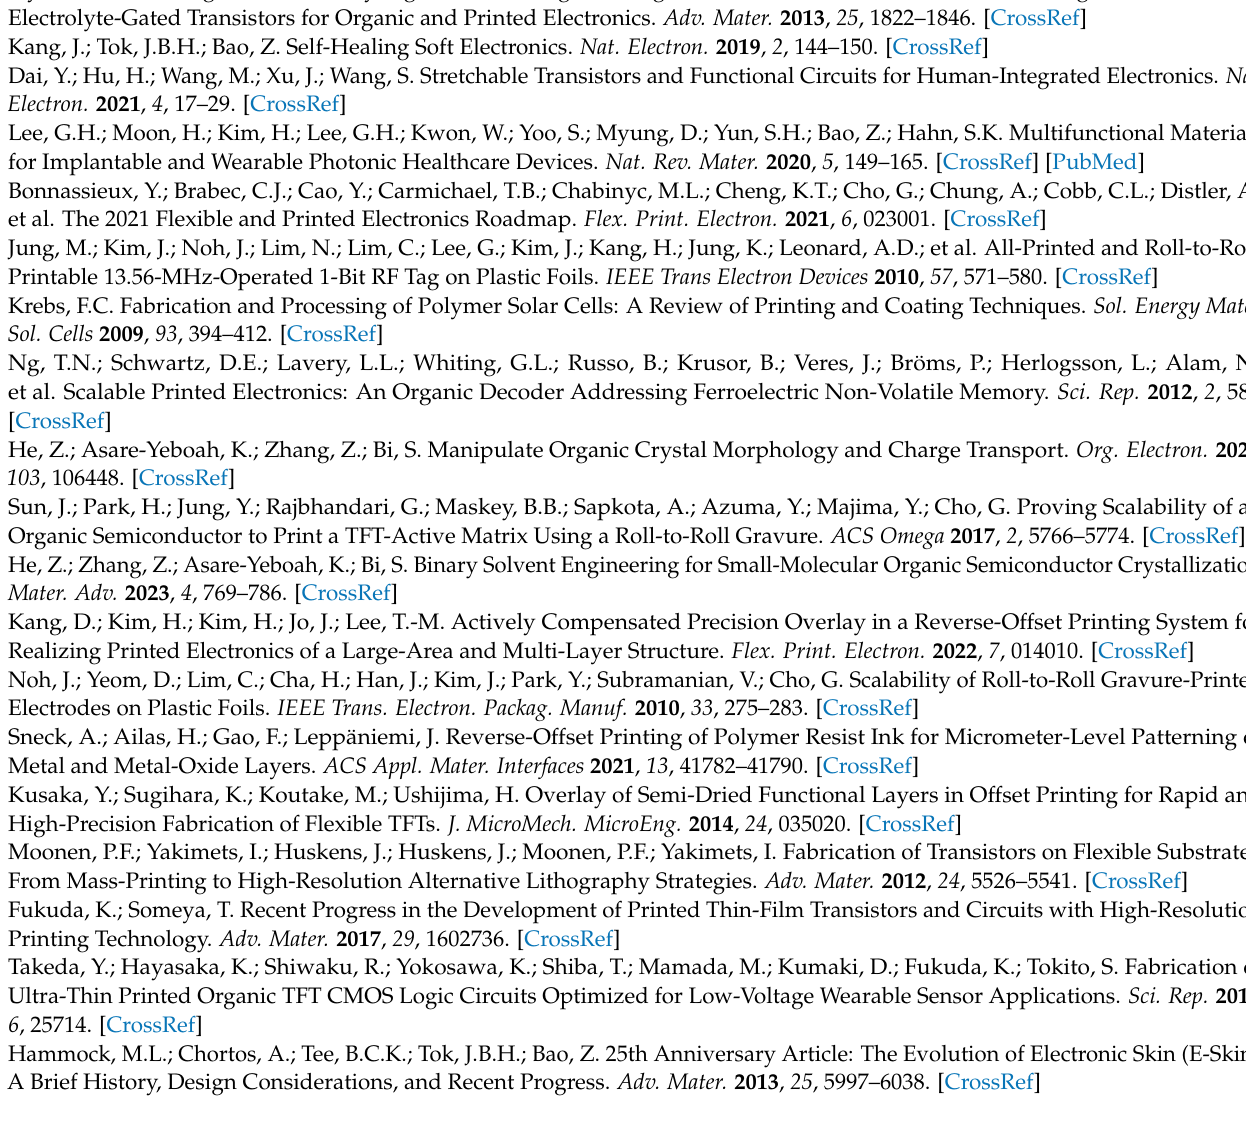
Table S3: tension and nip force data; Table S4: MD and TD camera trigger data; Table S5: mapping tension and nip force data to MD and TD camera trigger